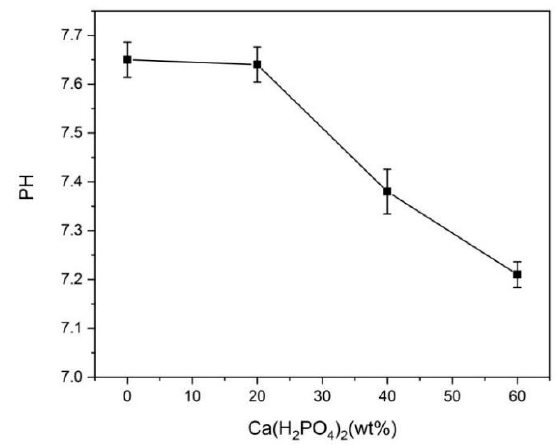
Figure 3. pH of BMPC extracts with Ca(H 2 PO 4 ) 2 .